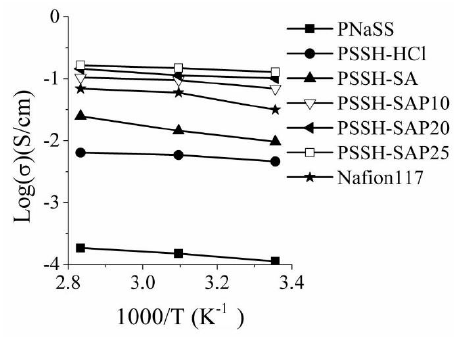
Figure 2. Through-plane conductivity vs temperature for membranes in acid and salt forms.